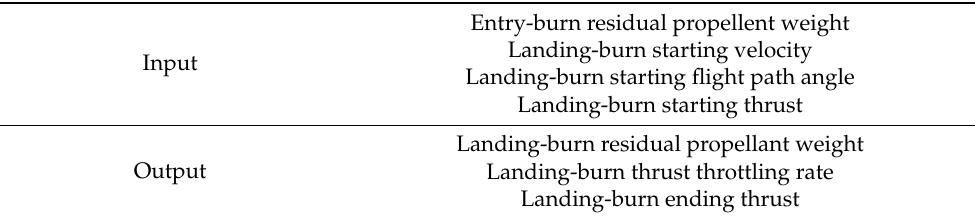
Table 5. Input and output parameters of the landing-burn